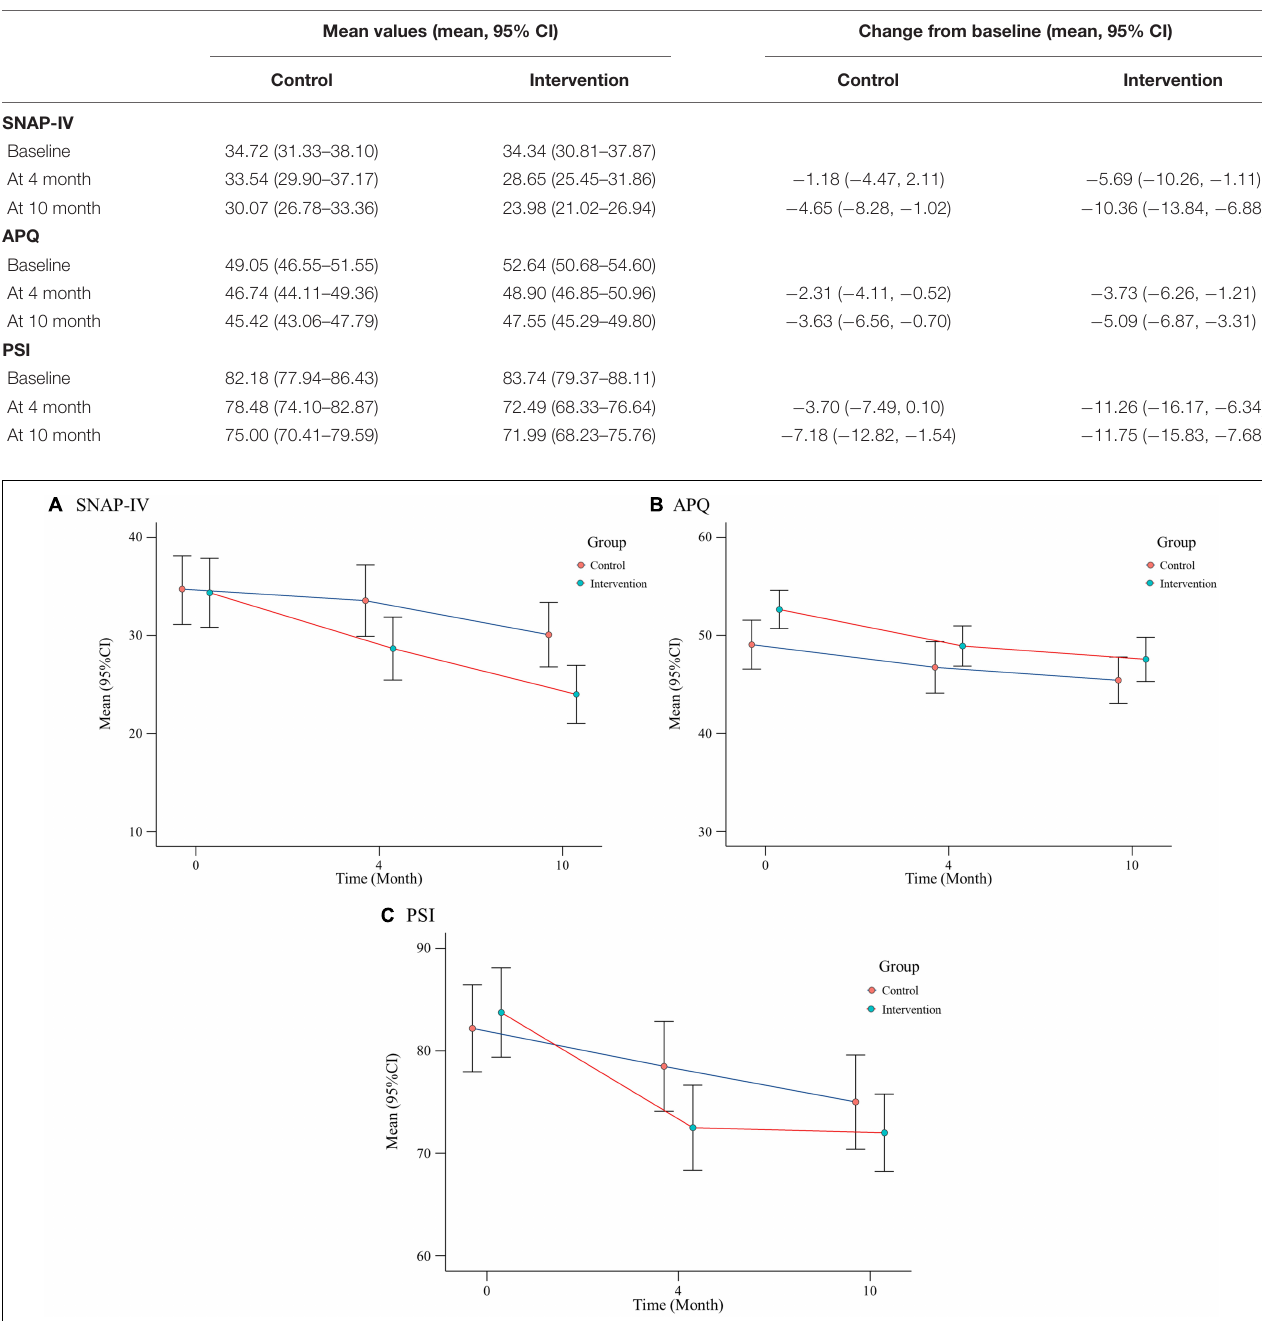
TABLE 2 | Mean values and changes from baseline for outcomes. Mean values (mean, 95% CI) Change from baseline (mean, 95% CI)